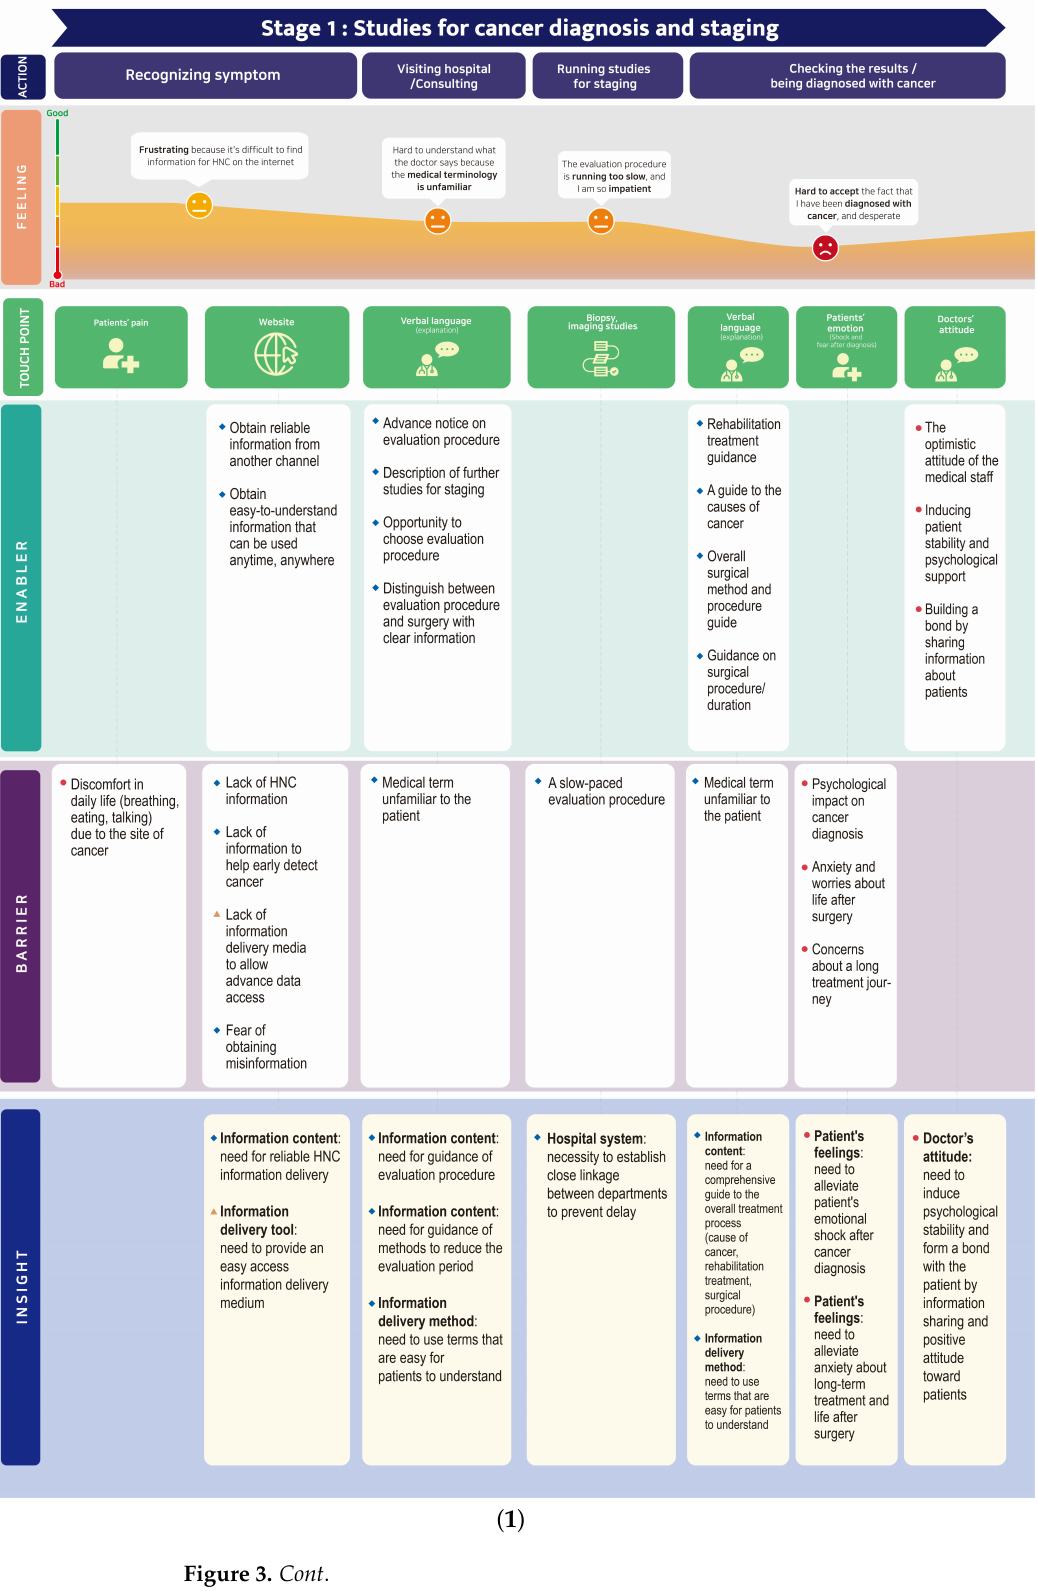
Figure 2. This is a wide figure. Figure 3. Cont